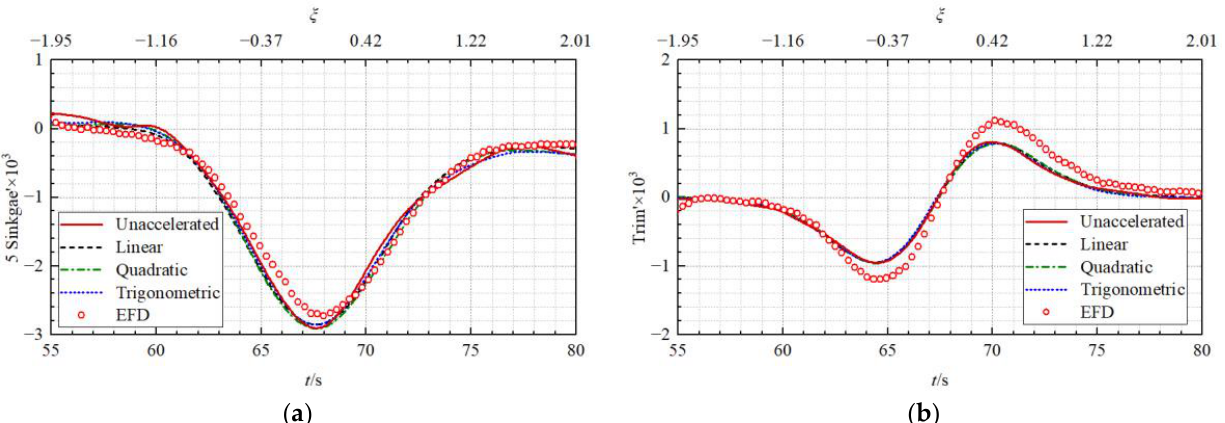
Figure 12. Time histories of free-surface elevations at the wave gauge position under the impacts of the primary wave system.